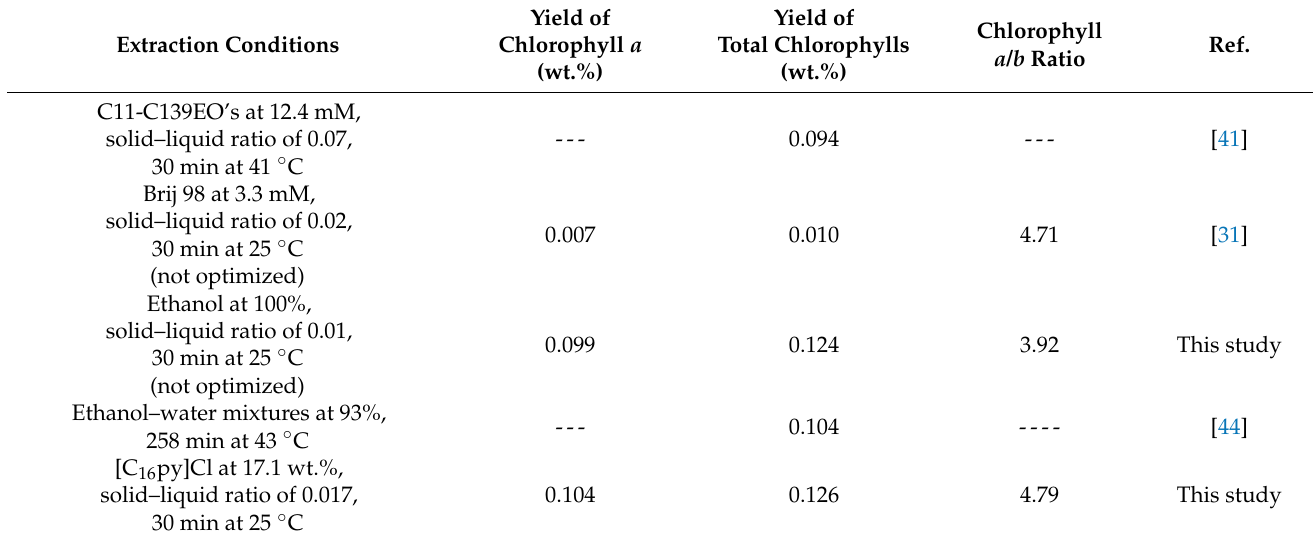
Table 1. Summary of the results obtained in this study and in the literature on the extraction of chlorophylls. Extraction Conditions